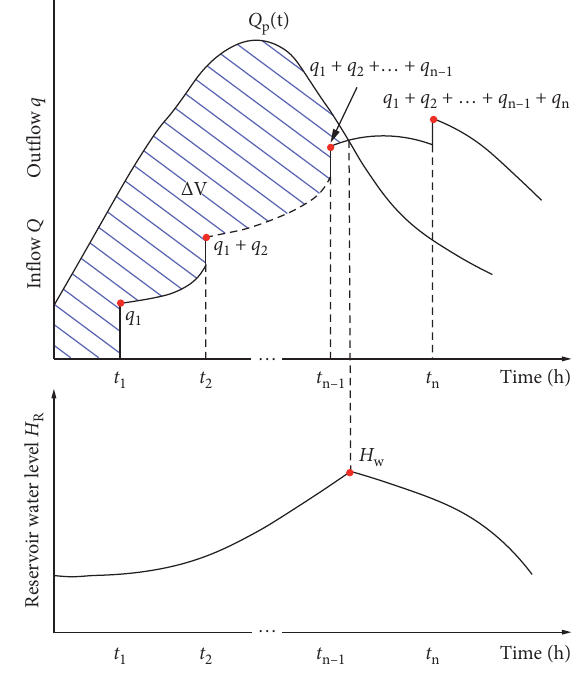
Figure 2: An illustrative example of reservoir routing considering failure duration of release